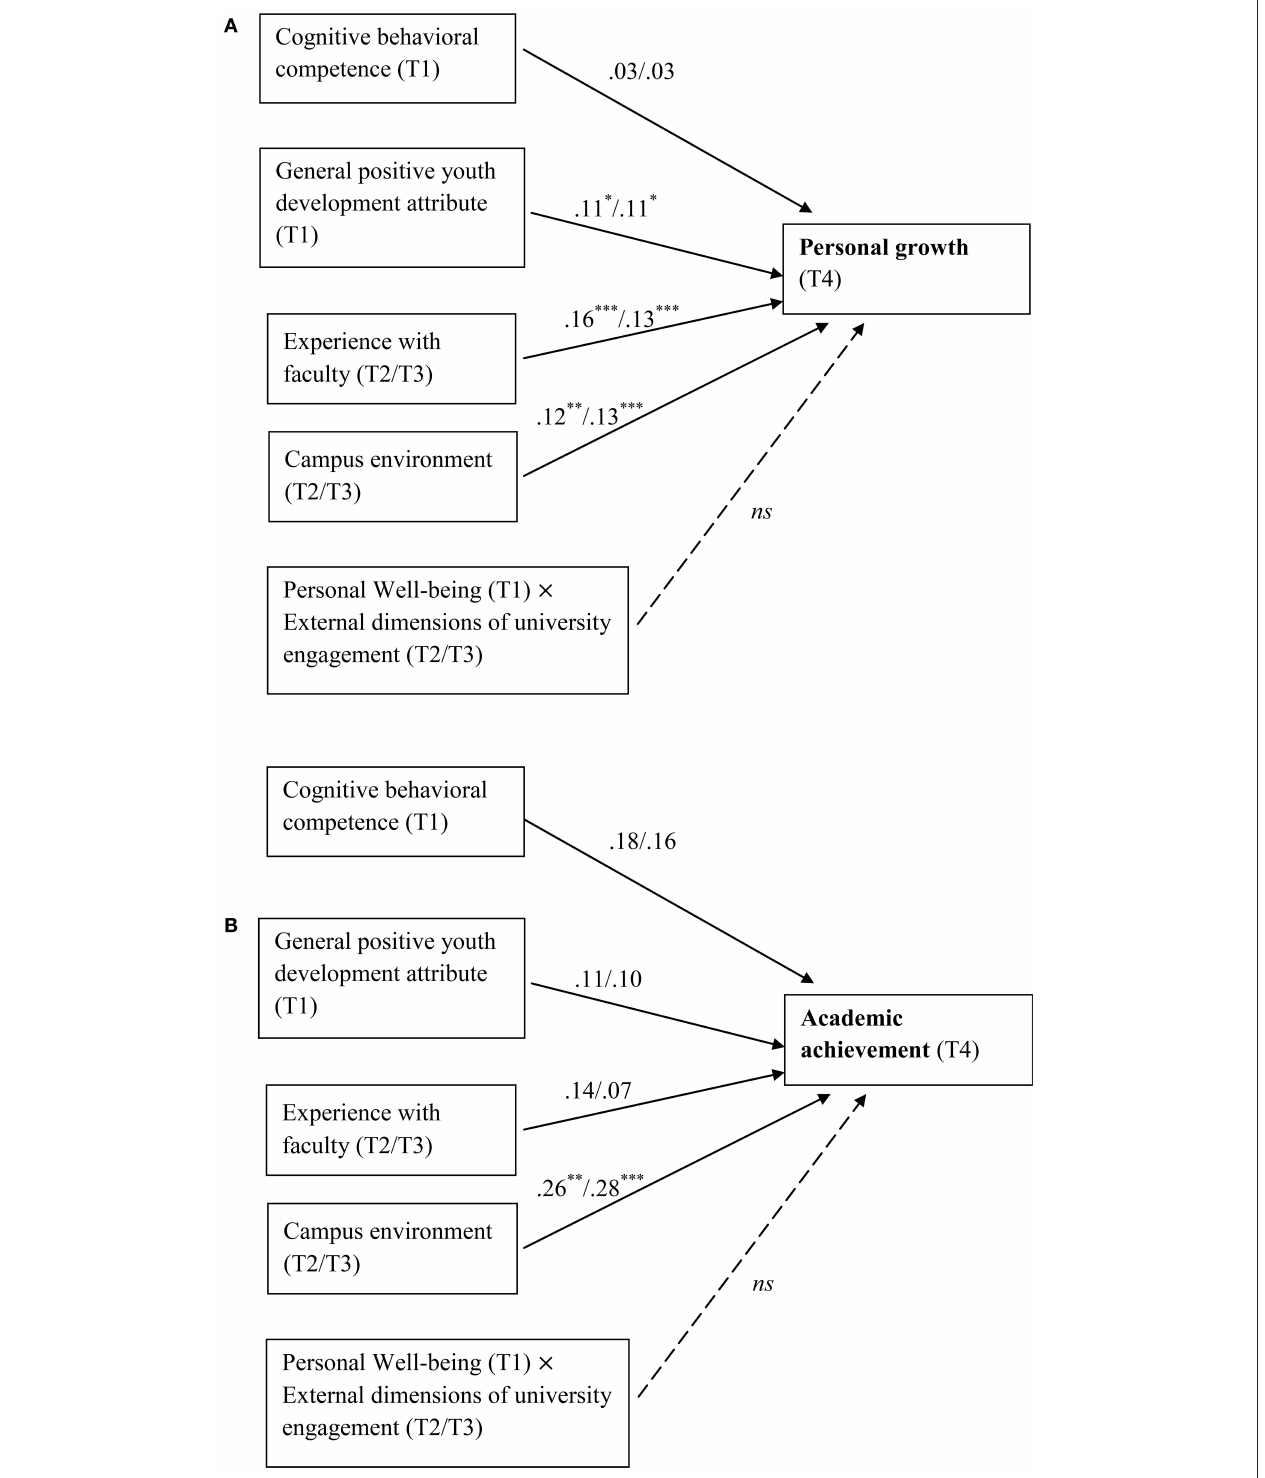
FIGURE 4 | (A) Relationships among personal well-being, personal growth, and external dimensions of university engagement. T1 = Time 1; T2 = Time 2; T3 = Time 3; T4 = Time 4. The regression coefficients shown in the figure are unstandardized values with values before and after slash representing using Time 2 and Time 3 external dimensions of university engagement, respectively. (B) Relationships among personal well-being, academic achievement, and external dimensions of university engagement. T1 = Time 1; T2 = Time 2; T3 = Time 3; T4 = Time 4. The regression coefficients shown in the figure are unstandardized values with values before and after slash representing using Time 2 and Time 3 external dimensions of university engagement, respectively. * p < 0.05; ** p < 0.01; *** p < 0.001.